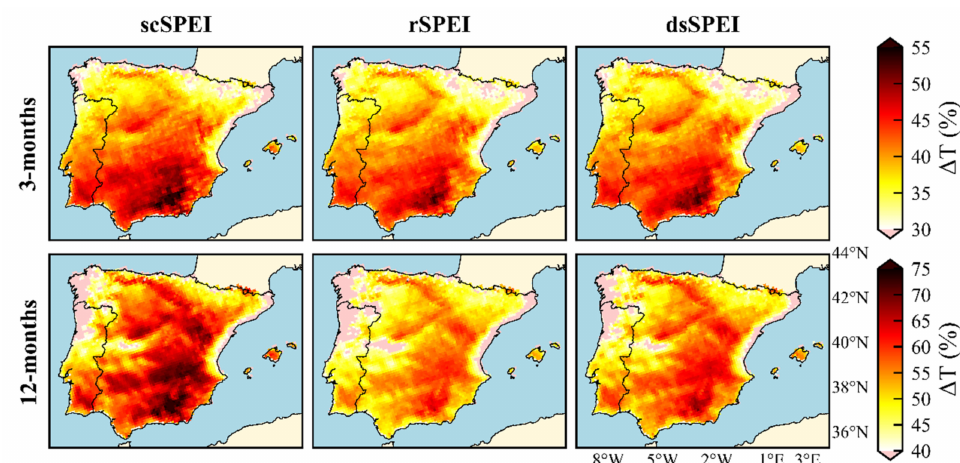
Figure 11. Changes (future minus recent past) in the percentage of time spent in droughts ( ∆ T, %) for the three methods analyzed (scSPEI, rSPEI, and dsSPEI) and at both timescales (3- and 12-month) for the far future. The dashed areas